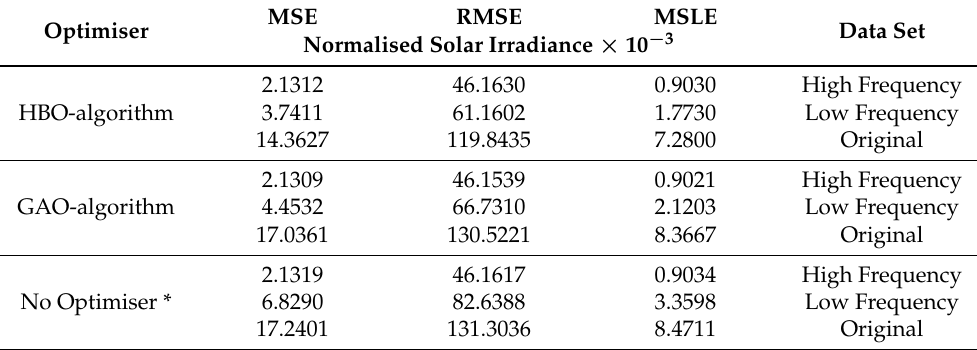
Table 2. Comparison of Optimisers using Error Parameters for different data inputs.